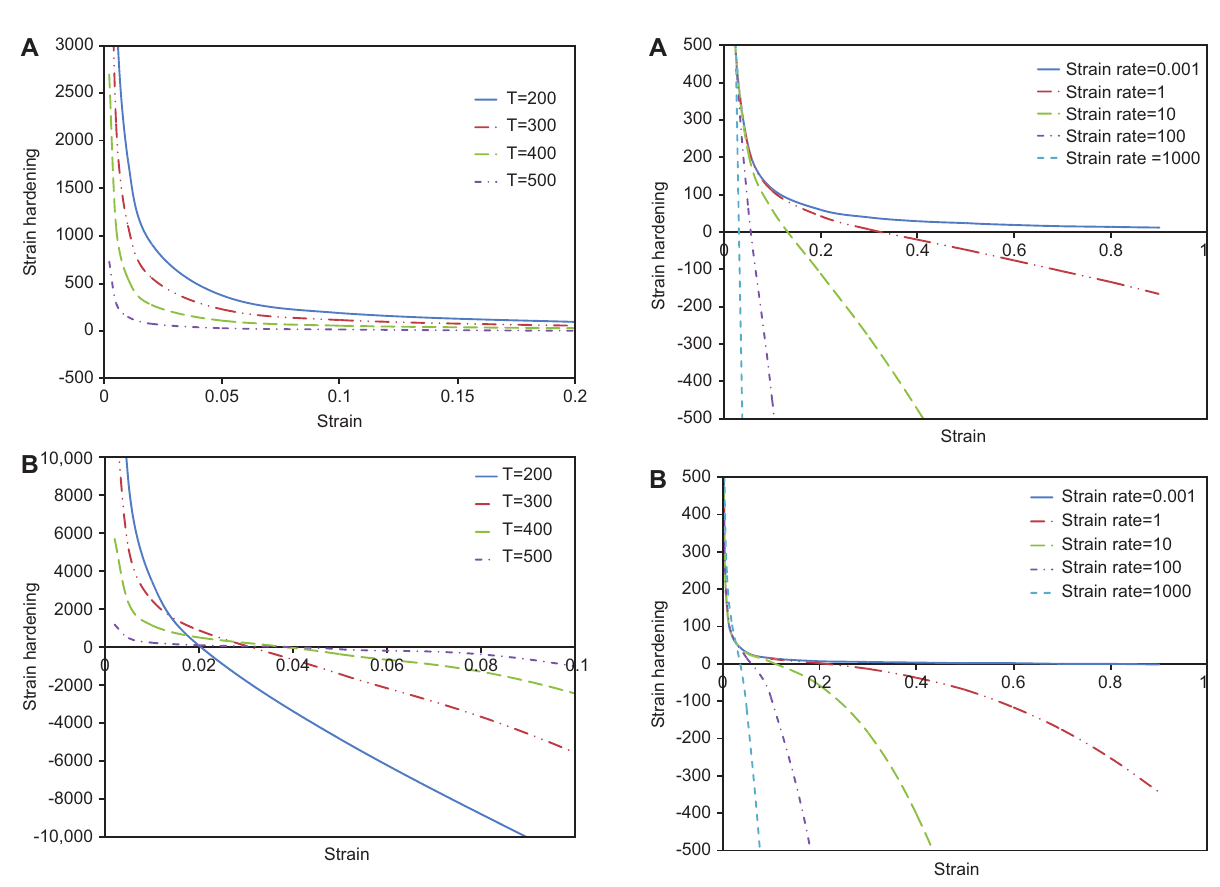
Figure 13 Change of strain hardening vs. strain of CR-1018 steel for different strain rates at temperatures of (A) 300 K and (B) 500 K.